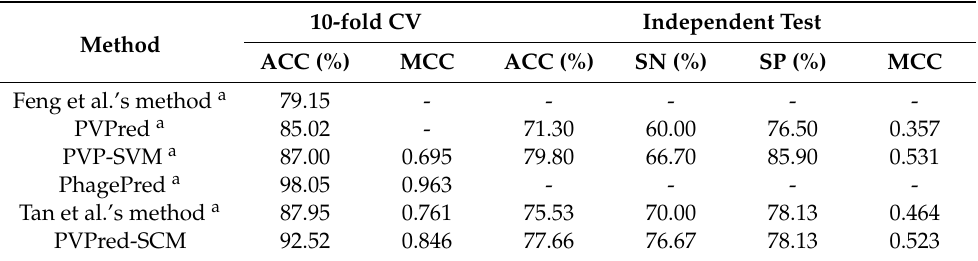
Table 5. Performance comparisons between PVPred-SCM and existing methods as assessed by the 10-fold cross-validation and independent validation